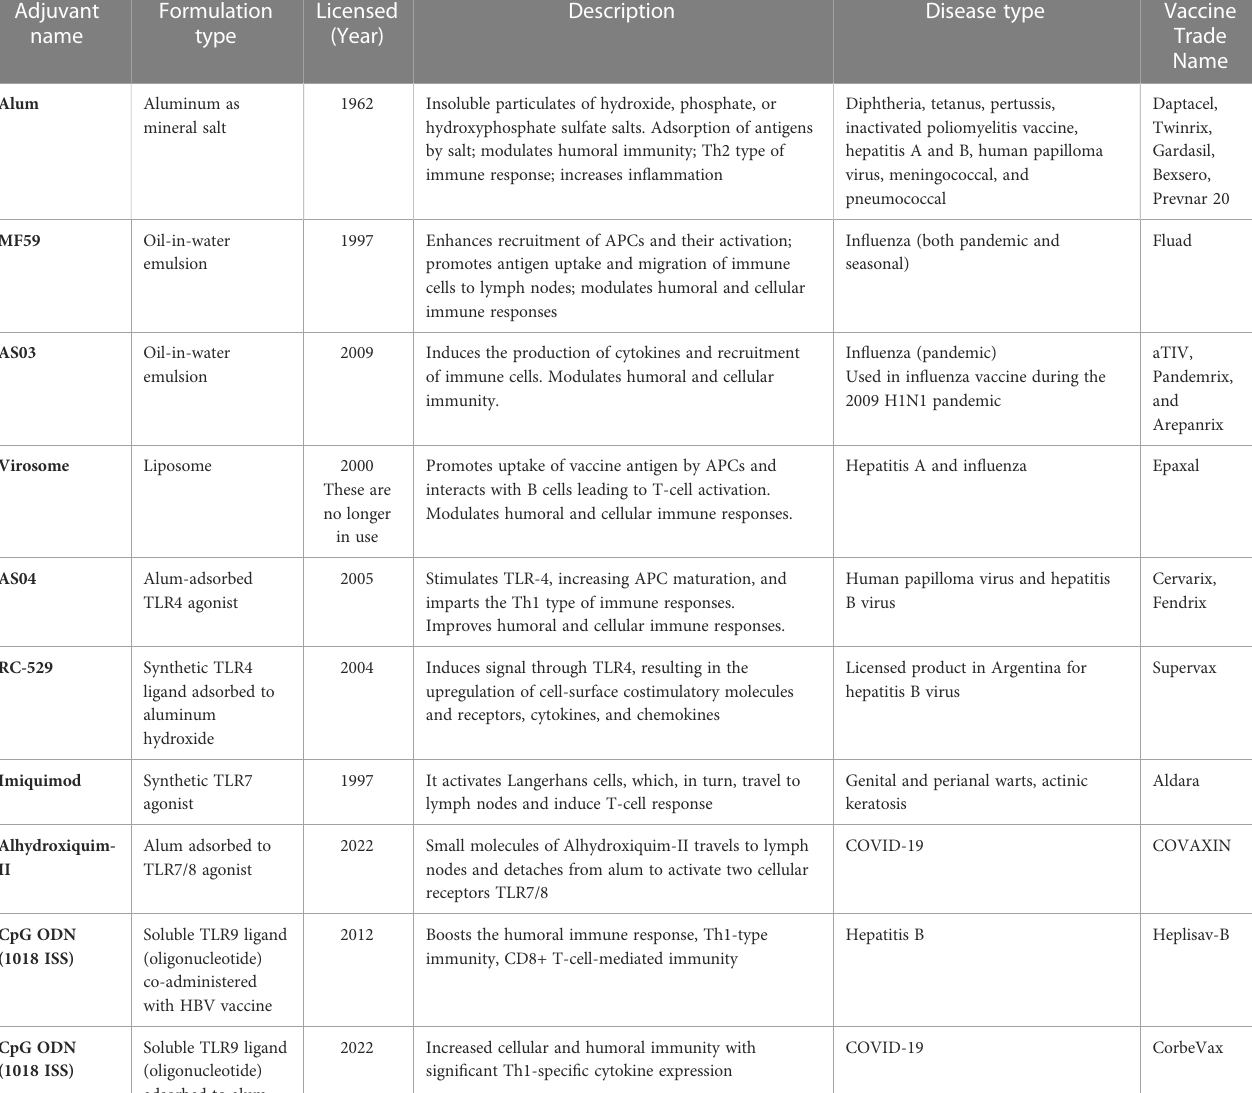
TABLE 1 Licensed vaccine adjuvants for human use. Adjuvant